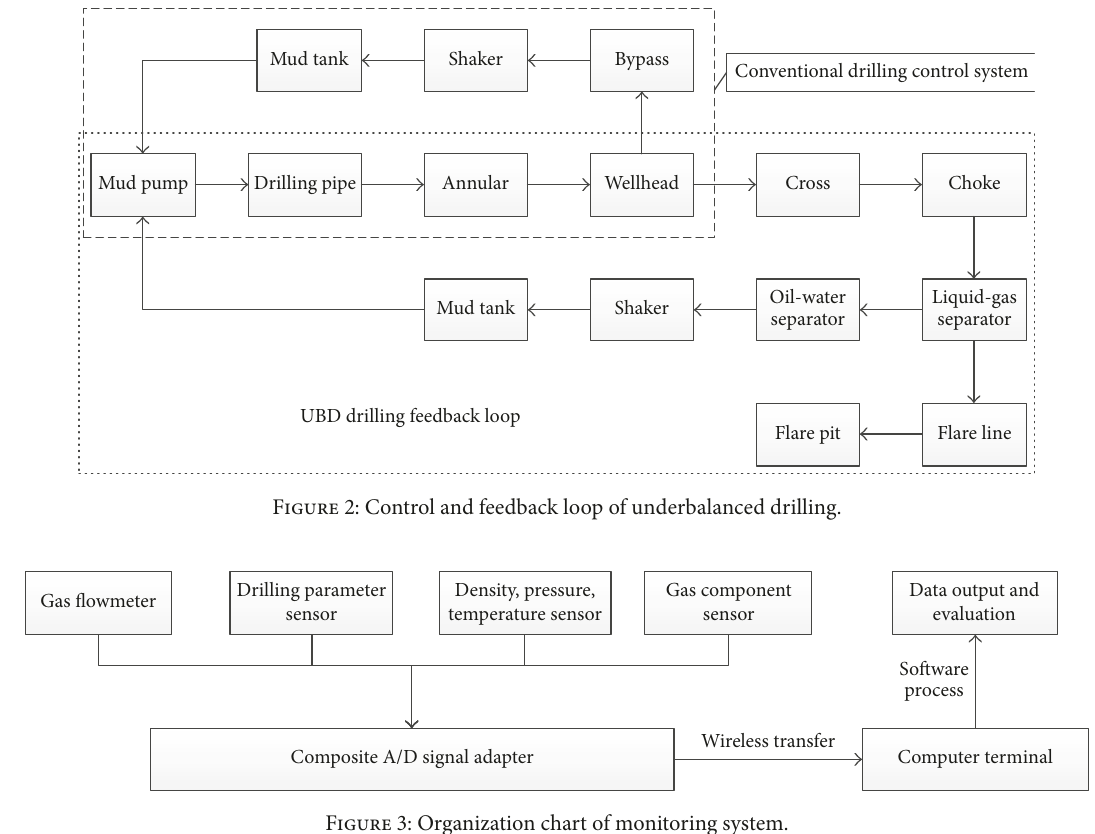
Figure 3: Organization chart of monitoring